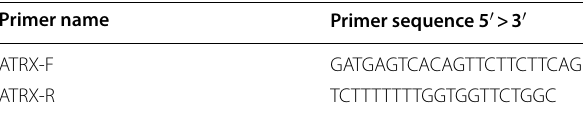
Table 1 PCR primers used for the PCR-sequencing of exon 9 of ATRX gene